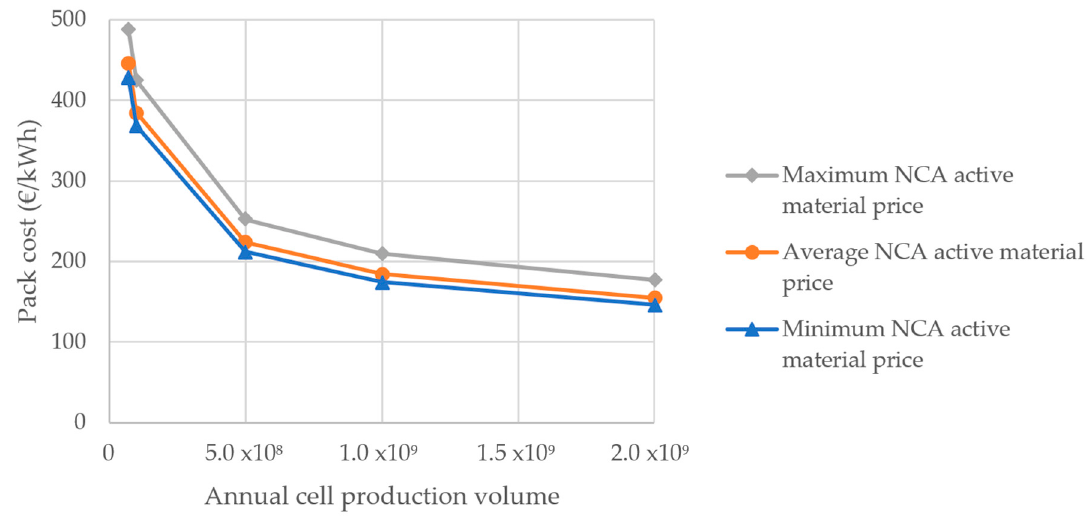
Figure 5. Cost of a 20-kWh pack manufactured in Korea for a range of NCA active material costs.